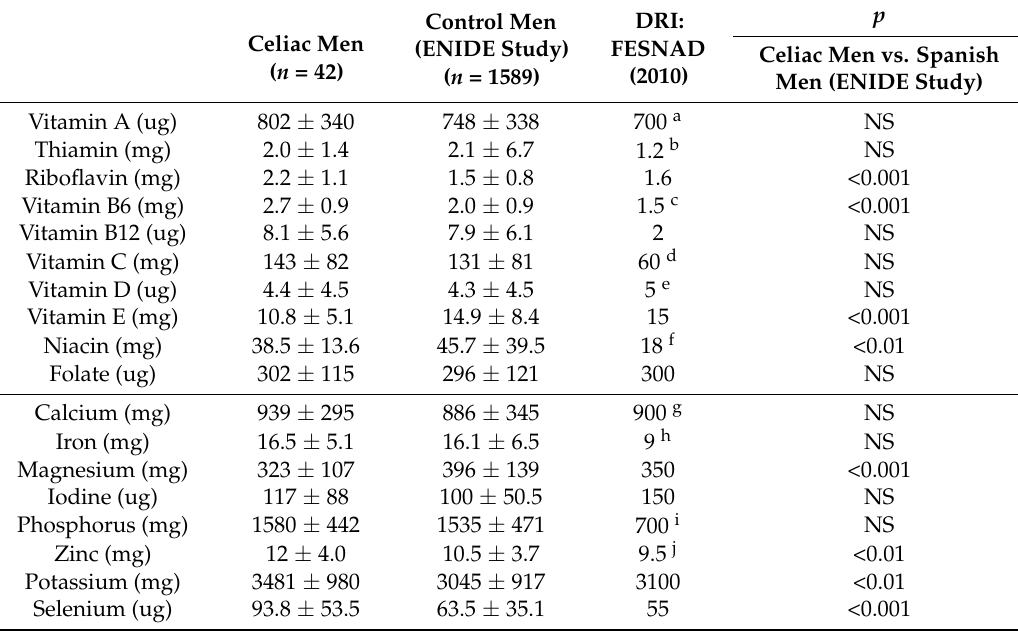
Table 4. Micronutrients mean intake in celiac and Spanish men.